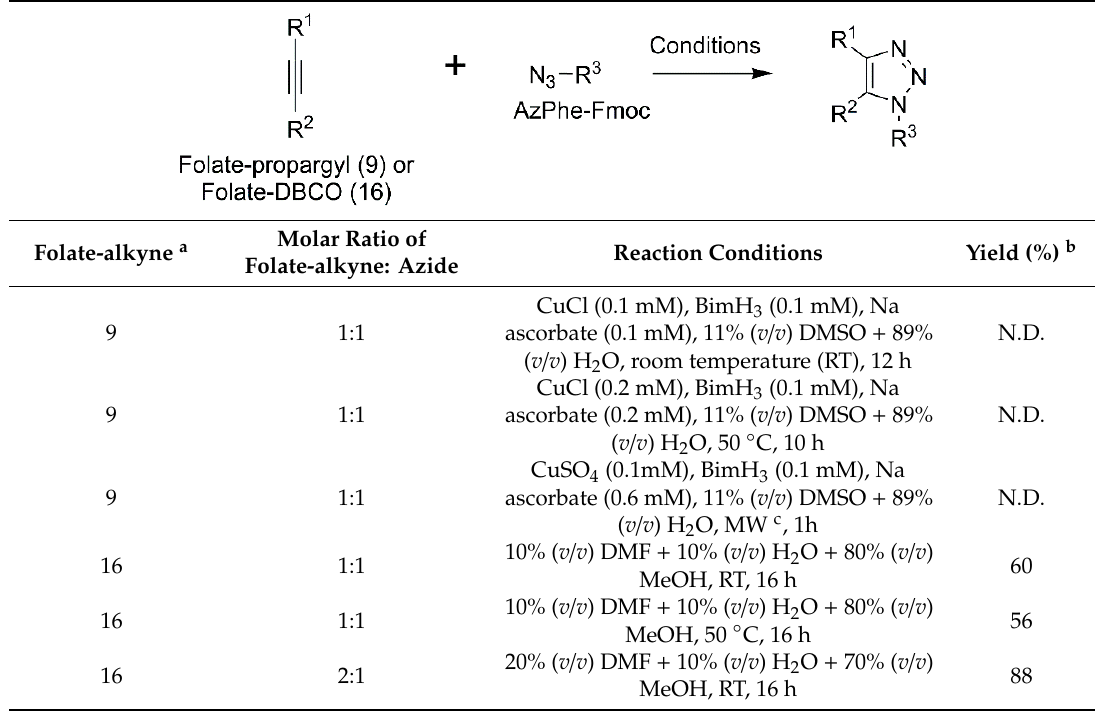
Table 1. Reaction conditions of folate-propargyl or folate-DBCO with AzPhe-Fmoc.